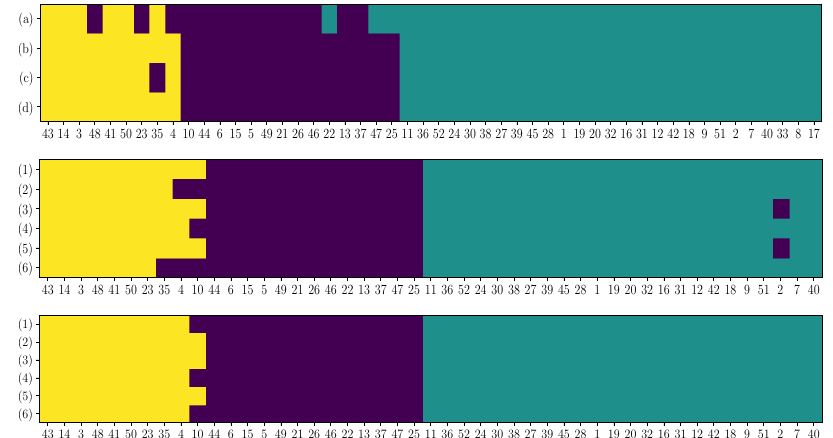
Figure 10. Clustering of individuals according to the DRN-based indicator extraction and regression. In first row, notations (a), (b) ,(c), and (d) stand for the corresponding items in Figure 9. The last two rows show the cluster of the DRN-based indicator ξ ∗ = ξ 2 extracted from ( µ + β ) rhythms, removing 10 trials consecutively in six runs with 2CH and 6CH electrode configuration,